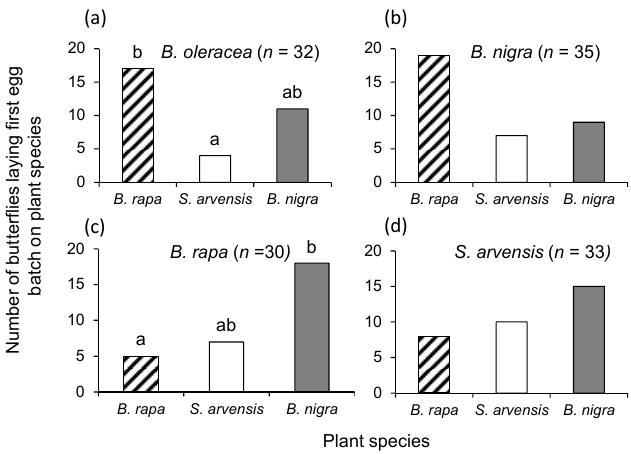
Figure 1. Oviposition preference of female Pieris brassicae that had been reared on: Brassica oleracea ( a ); Brassica nigra ( b ); Brassica rapa ( c ); and Sinapis arvensis ( d ) in a three-way choice assay with B. rapa ( dashed bars ), S. arvensis ( white bars ), and B. nigra ( grey bars ) plants. Bars represent the total preference number, and bars with the same letter are not significantly different from each other (pairwise χ 2 test with a Bonferroni correction for multiple comparisons Type I errors). Samples sizes are given in brackets.